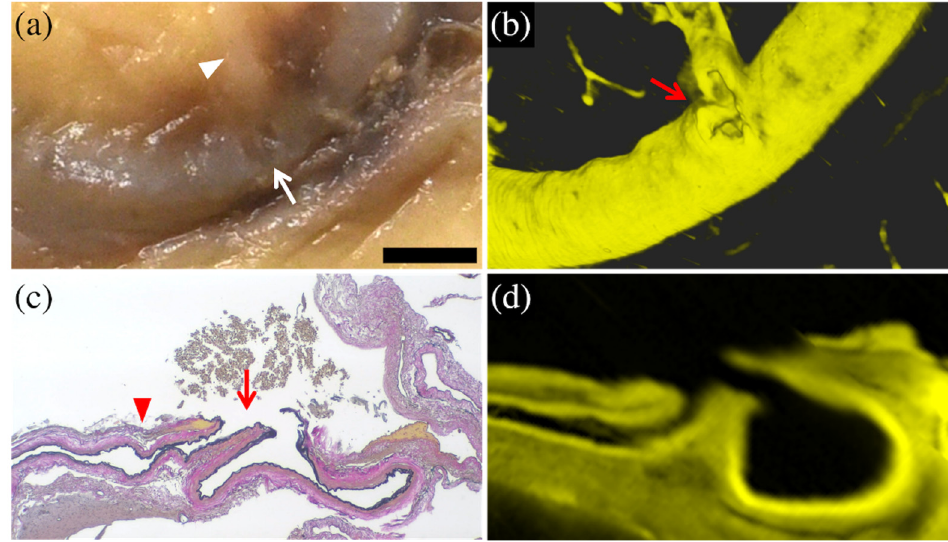
Figure 2. Comparison of macroscopic and histopathological images with CUBIC images in case 1. The enlarged macroscopic (formalin-fixed) image ( a ) showed the cortical artery with a small depression (arrow) and fine arterial branch (arrowhead). The 3D-CUBIC image ( b ) clearly showed the cortical artery ruptured at the base of a fine branch (arrow). The histopathological (Elastica van Gieson staining) image ( c ) showed a tear of the arterial wall (arrow) at the base of a fine arterial branch (arrowhead). The cross-sectional CUBIC image ( d ) reconstructed the morphology of the rupture as well as the his- topathological image. The bar (on the lower right side of ( a )) is equal to 2 mm for ( a ) and ( b ), 500 μ m for ( c ), and 700 μ m for ( d ). The panels ( a , c ) are modified from the study by Funayama et al. [52].